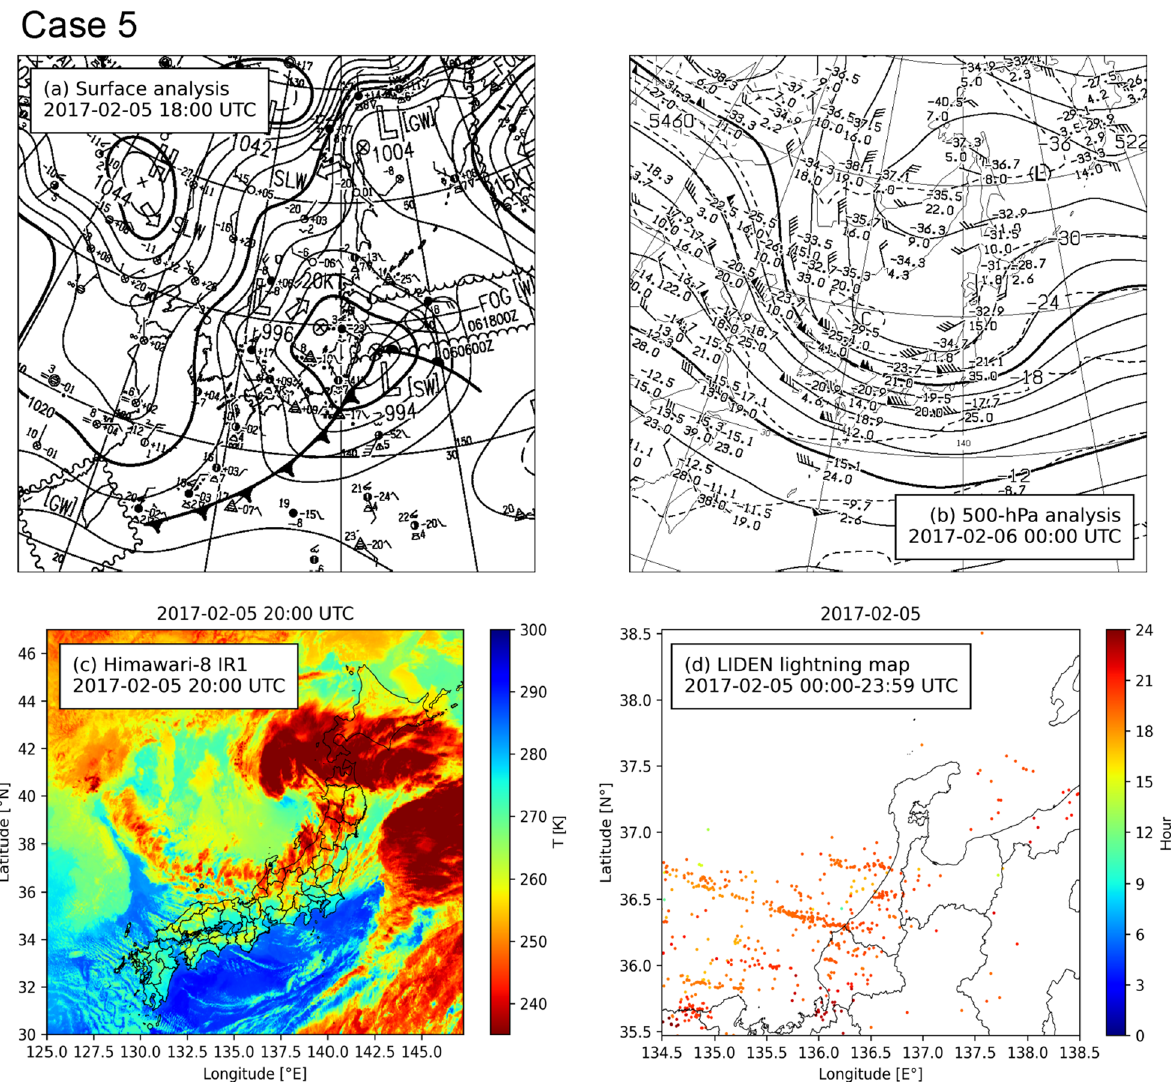
Fig. 7 Meteorological charts of the glow-detection case 5 in the same format as Fig.